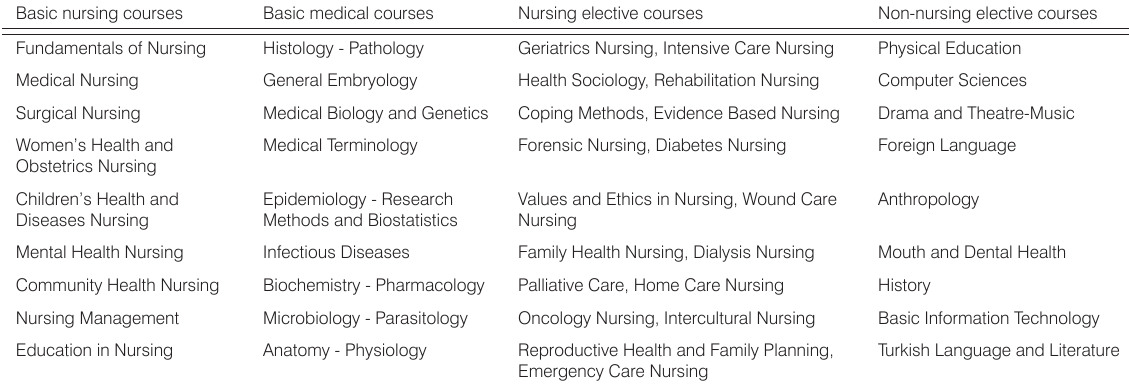
Table 1. The courses of nursing